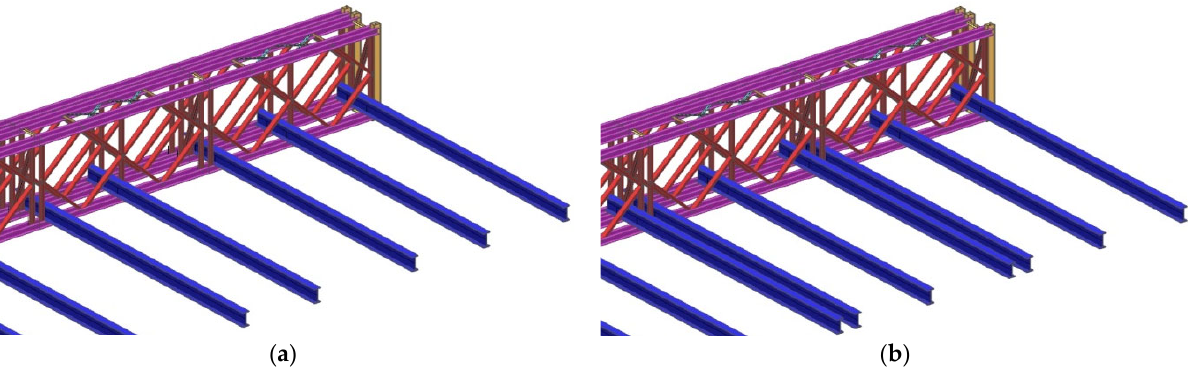
Figure 5. Two alternatives of construction arrangement of cross beams: ( a ) 3 cross beams within each panel; and ( b ) 2 cross beams within each panel.